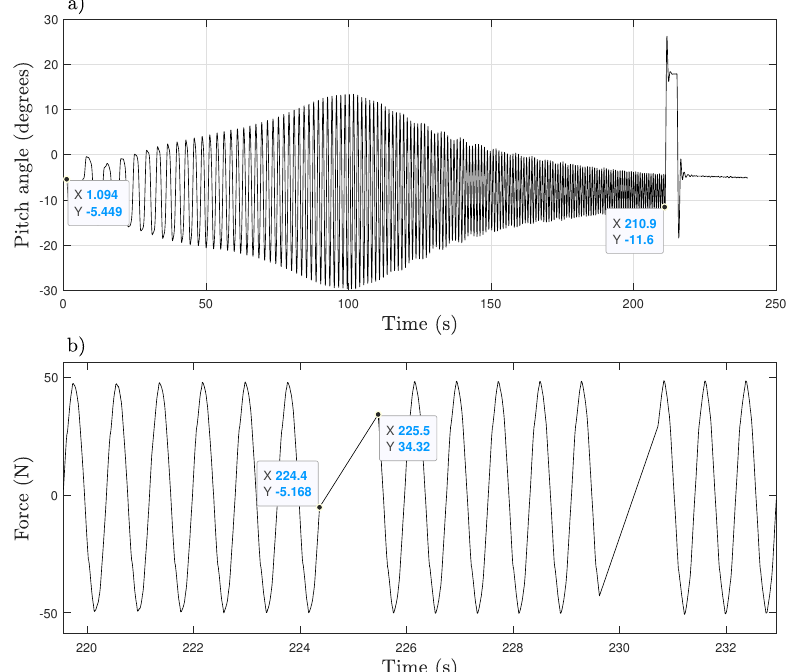
Figure 6. Typical dropouts found in the experimental data. ( a ) Aft Angle Sensor—85 Newtons; ( b ) Fore Force Sensor—53